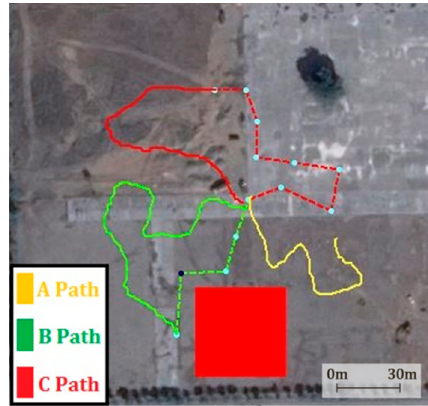
Figure 21. The new path (two dashed lines) generated by failure complementation.